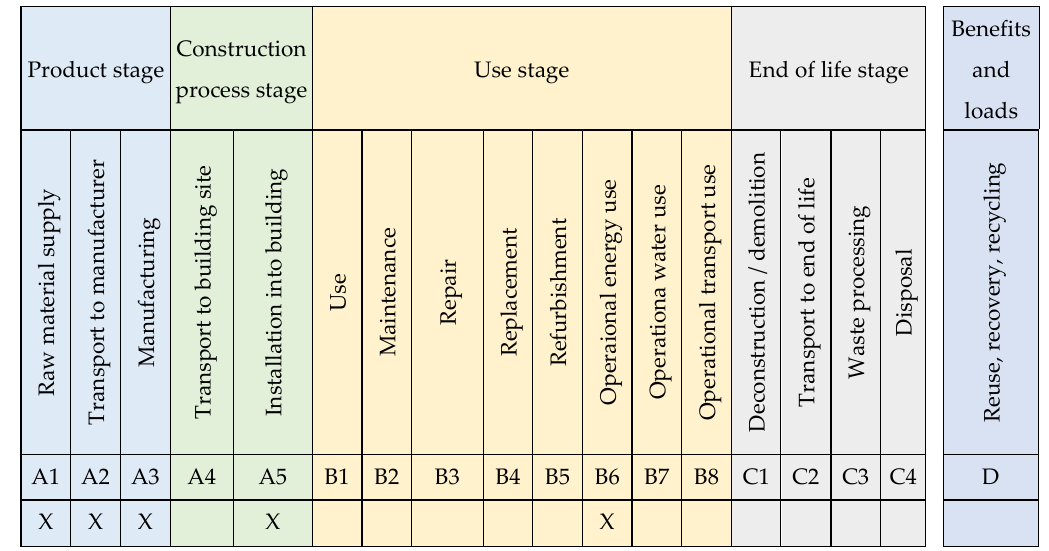
Figure 2. Life cycle modules based on NS3720 and EN15804.